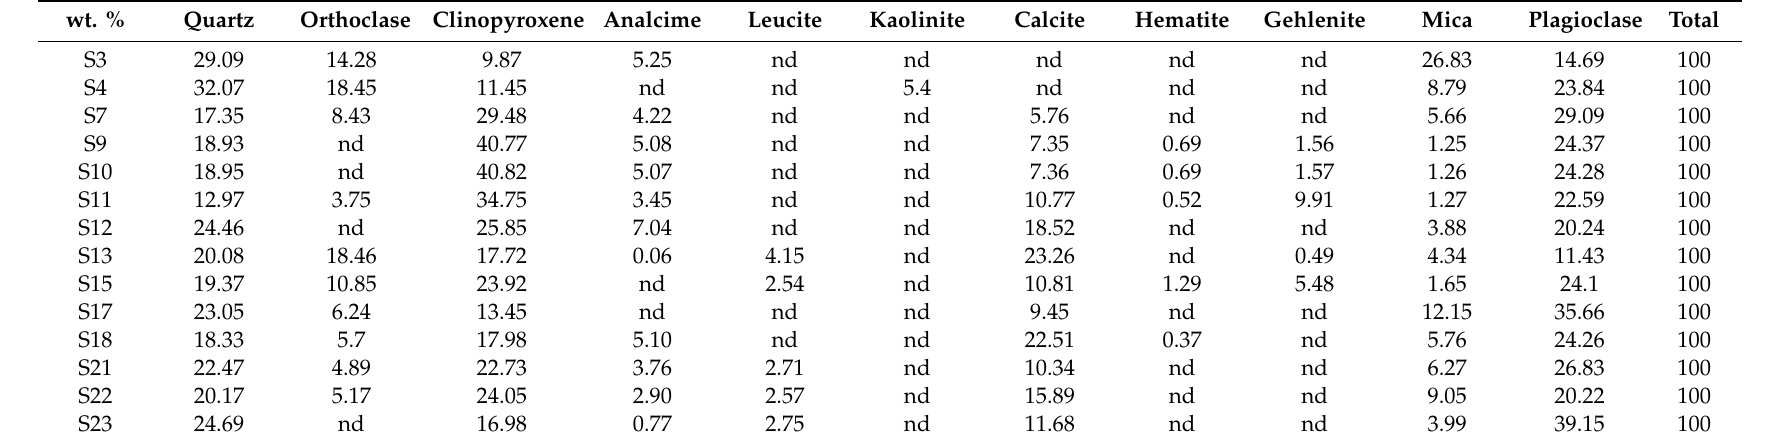
Table 4. Quantitative mineralogical composition of the architectural earthenwares by XRPD analysis and Rietveld refinements. nd: not detected. wt.